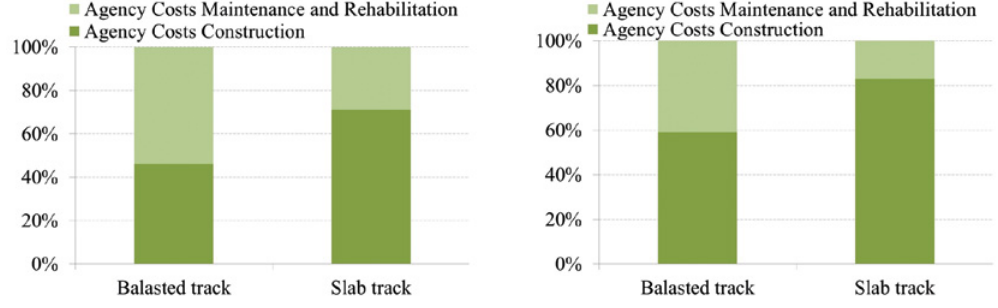
Figure 7. Construction versus Maintenance and Rehabilitation Costs for ballasted track and slab